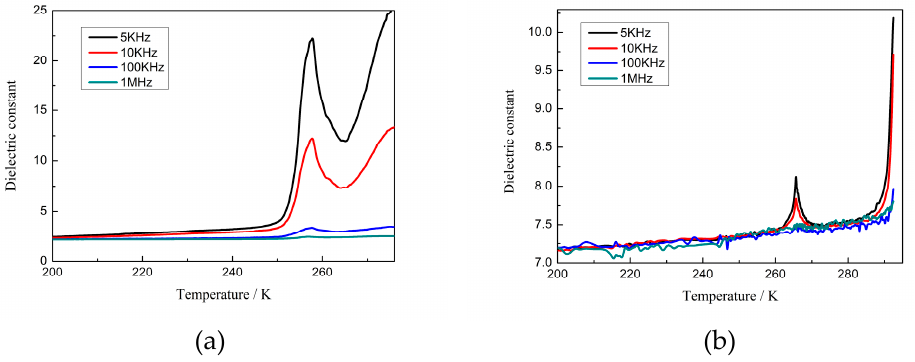
Figure 6. Dielectric properties for crystal 1 ( a ) and 2 ( b ) measured as a function of temperature under a frequency of 5 KHz to 1 MHz.